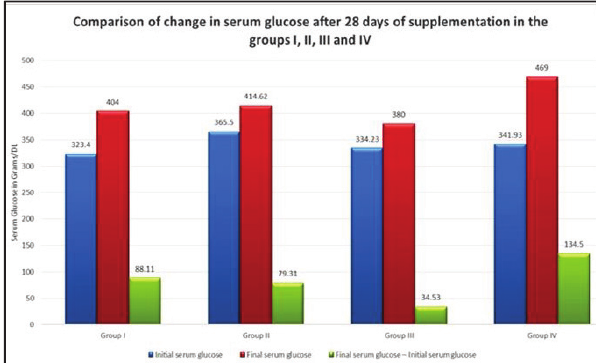
Fig-2: Comparison of change in serum glucose after 28 days of supplementation in the groups, I (Diabetic Control), II (Cane Sugar), III (Honey), and IV (Jaggery). a Values are given as mean ± SD for normally distributed variables and median (IQR) for non-normally distributed variables. b p-value is generated by Paired Samples t-test. c p-value is generated by Wilcoxon Matched-Pairs Signed-Ranks Test. (p=0.001 is considered highly significant and p˂0.05 is considered significant).